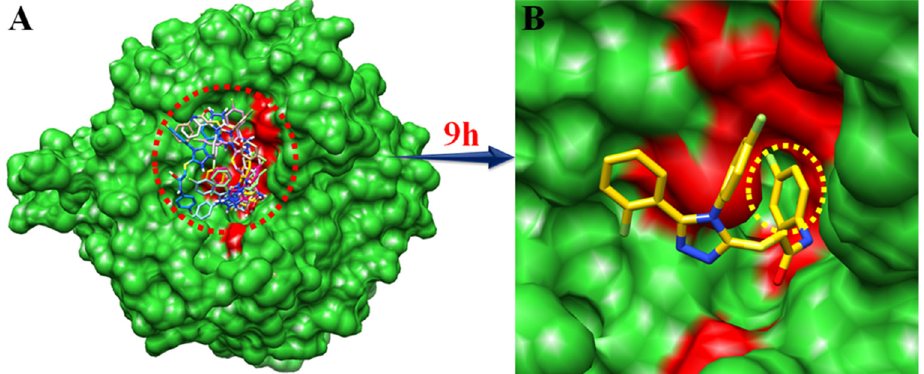
Figure 6. ( A ) Binding conformation of 9a–i , ( B ) Closed graphical depiction of 9h in the active region of the target protein. The receptor molecule is highlighted in a green color in the surface format whereas the red color represents the binding pocket of tyrosinase. The most potent ligand is highlighted in yellow, and their embedded moieties such as fluorine, amino group, and oxygen are shown in light green, blue, and red,